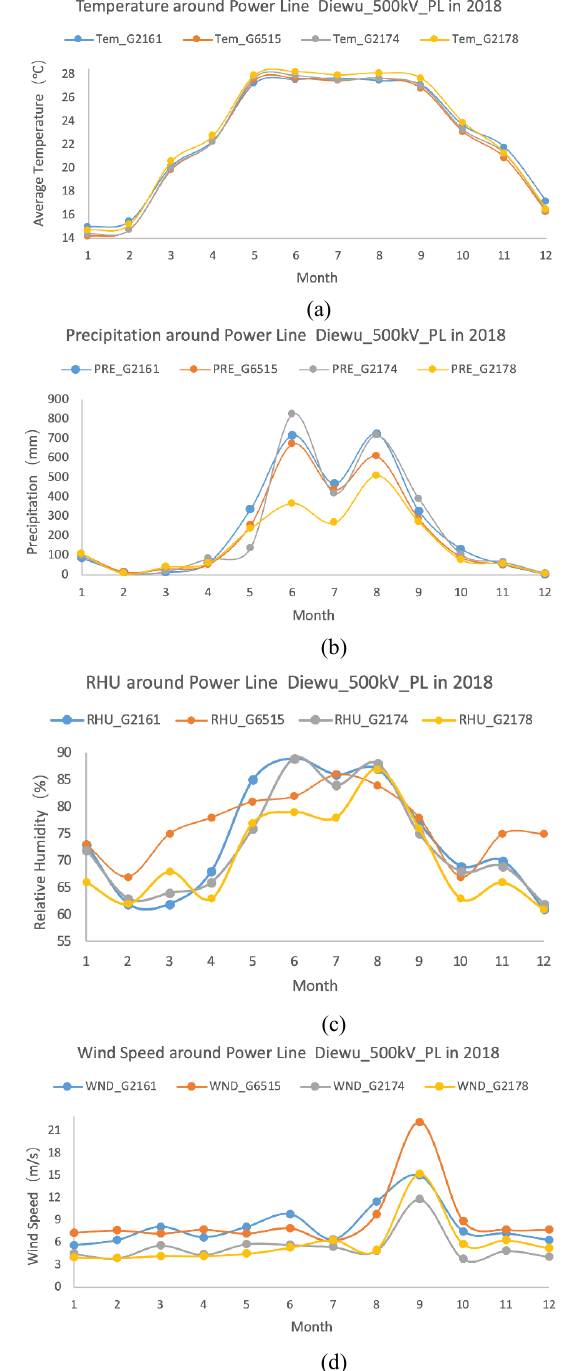
Figure 3 . Meteorological observation around Diewu_500kV HV TL: (a) daily average temperature in each month, (b) daily average precipitation from 20:00 to 20:00 in each month, (c) daily average minimum relative humidity in each month, (d) daily average maximum wind speed in each